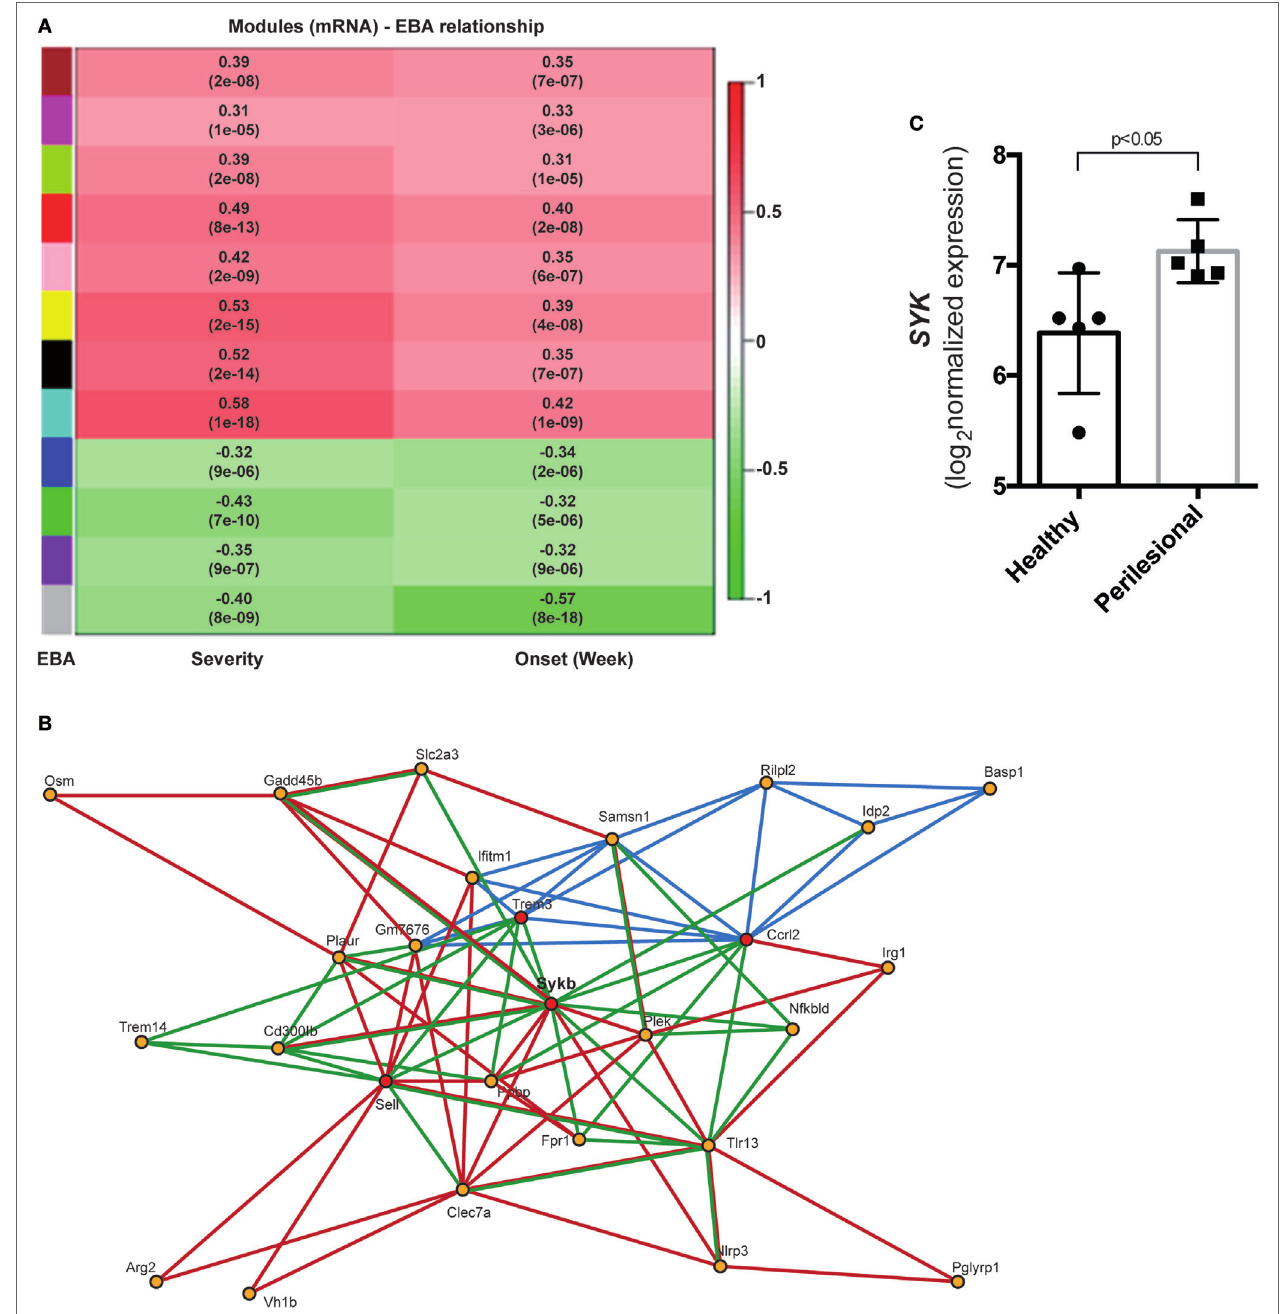
FigUre 1 | Differential co-expression of cutaneous mRNA expression levels in mice with experimental epidermolysis bullosa acquisita (EBA) identifies SYK as a major hub gene candidate. (a) We applied hierarchical clustering to cluster gene profiles and the dynamic cut tree method to combine branches and define co-expressed groups (modules) from the expression data. We found 12 modules and assigned them different colors, with gray used for genes that could not be assigned to any other module. To identify disease-related modules, we correlated module eigenvalues to the disease score for EBA severity and onset. Bar on the left corresponds to modules, and bar on the right displays the range for Pearson correlation (from − 1 to 1). Data are derived from 68 mice with experimental EBA and 122 mice that remained healthy after type VII collagen immunization (17). (B) This image shows the gene network of the yellow module. Red lines display the interaction information from STRING database. Green lines display predicted interactions using domain interaction information. Dark blue lines represent PLSR-based interactions. Red circles indicate hub genes. (c) In patients with bullous pemphigoid, which shares a lot of similarity with the inflammatory EBA variant (2), we observed an increased SYK expression in perilesional, as compared to non-affected skin of corresponding anatomical